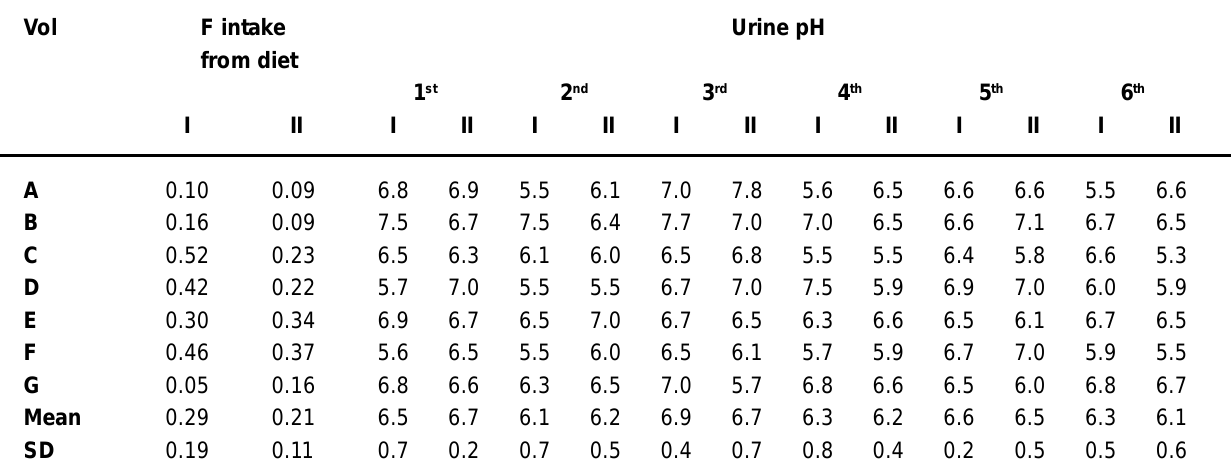
TABLE 2- Fluoride intake (mg) from the diet and pH values of the 6 urine samples collected, for each volunteer (Vol) at phases I (Duofluorid) and II